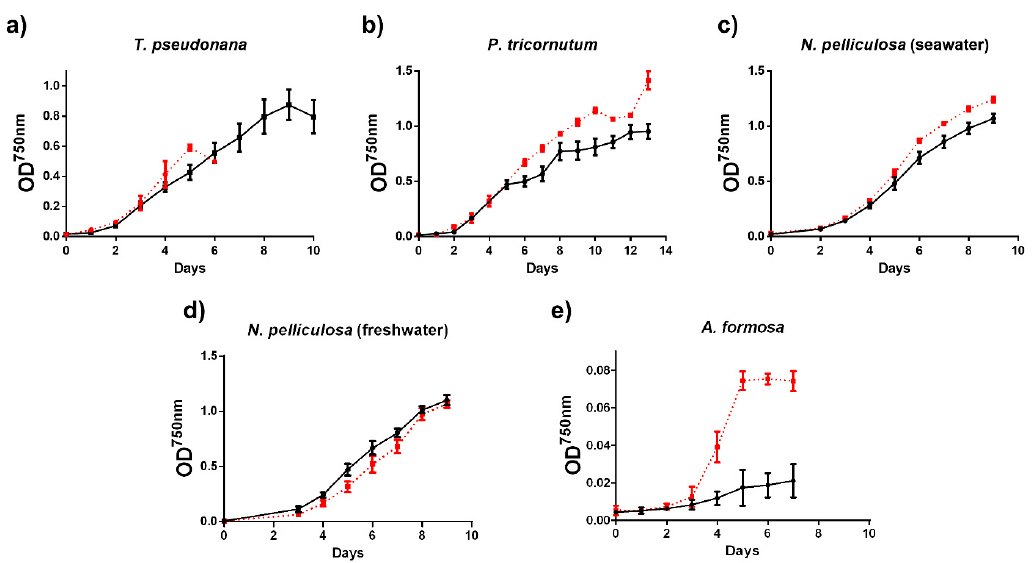
Figure 1. Growth curves of diatoms (a–e) grown at low (400 ppm; black and solid lines) or high (20,000 ppm; red and dotted lines) CO 2 . Each point represents the average ( n = 3) ± SD. Table 1. Biomass and lipid (TAG) productivity and content in diatoms grown at di ff erent CO 2 concentration. Diatom Species T.